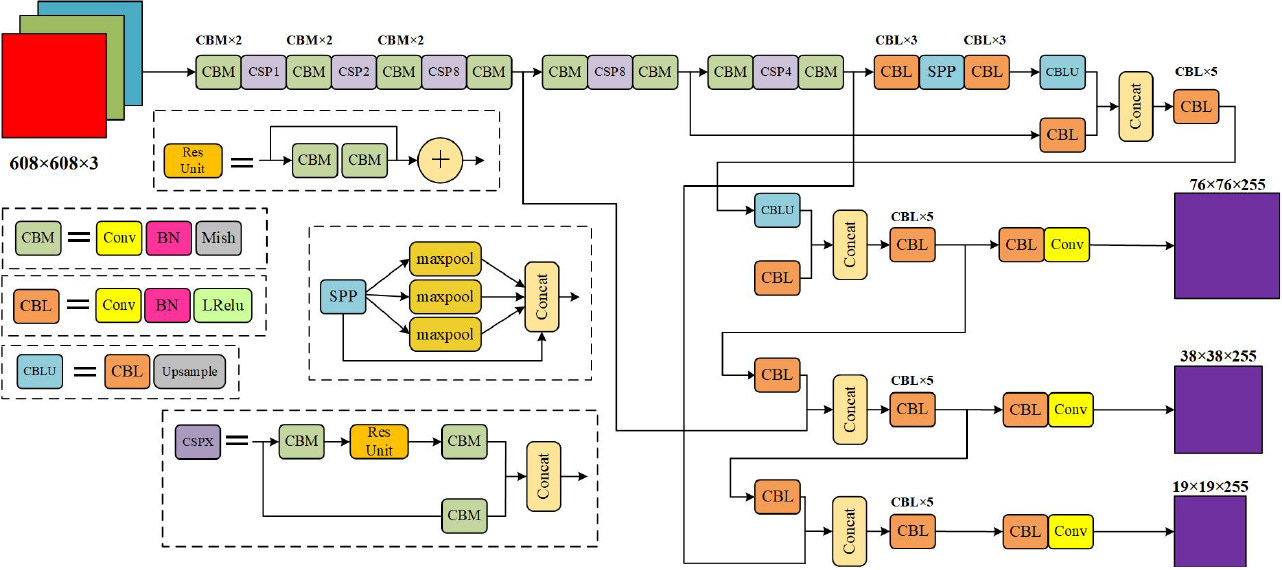
Figure 1. YOLOv4 model structure.